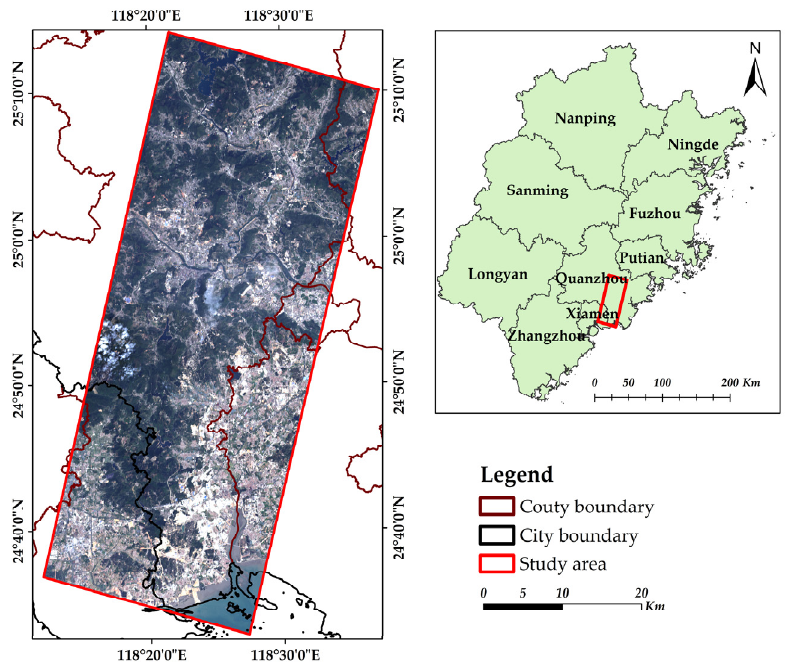
Figure 1. Location of the study area and map shown in true color image from Ziyuan-1-02D (ZY-1- 02D).